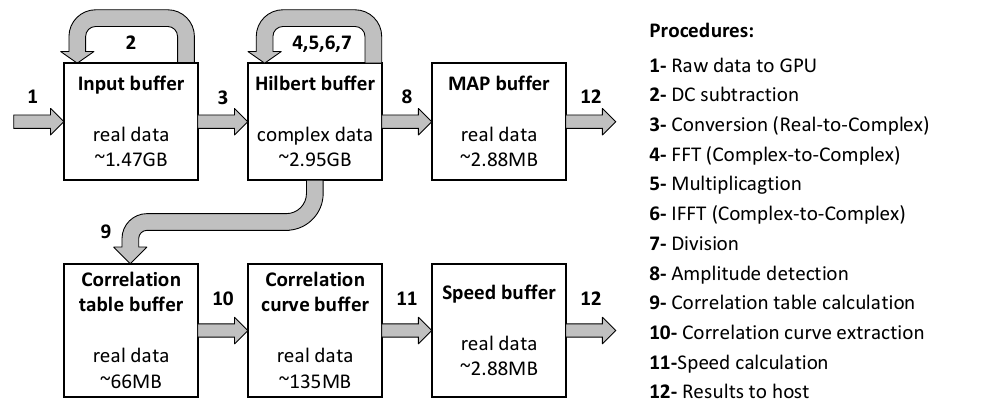
Figure 6. Data flow through the memory bu ff ers in GPU. All the bu ff ers in GPU were allocated with single precision. Procedures from 2 to 11 are kernel functions executed in GPU. Among these kernels, Hilbert transform is completed from 3 to 7 and correlation calculation is completed from 9 to 10.